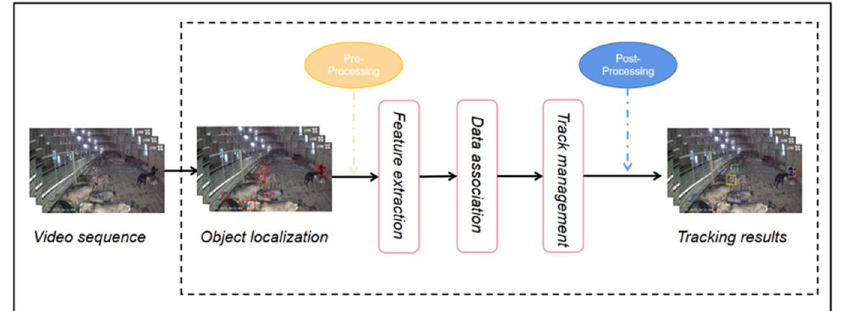
Figure 9. The flow chart of goat tracking.